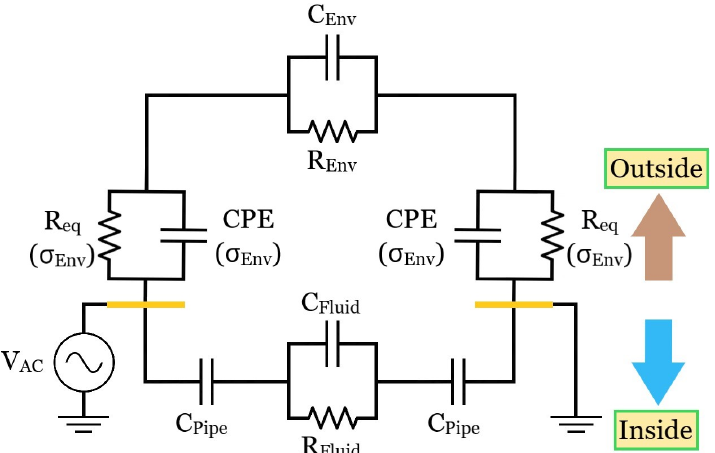
Figure 12. Refined equivalent circuit obtained via the thicker setup outcomes. Its yellow parts stand for three electrodes at virtual ground whereas the remaining four are at V DD . Furthermore, Req is the series between the polyimide and double layer resistances, the latter a function of environmental electrical conductivity ( σ Env ), whereas CPE( σ Env ) represents the Constant Phase Element. (2) Outer soil environment (shallow terrain) : As advocated for in Section 3.1.2, the electric